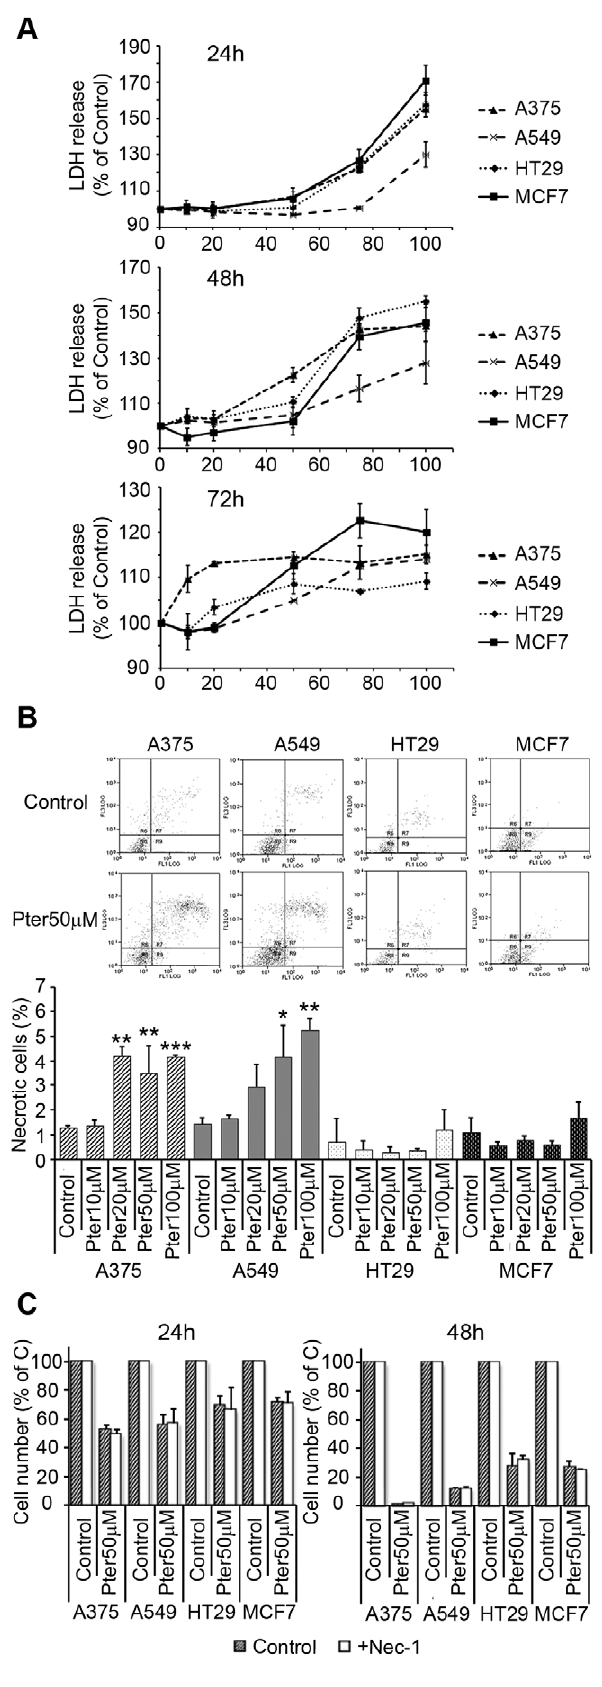
Figure 5. Effect of pterostilbene on necrosis induction. A) Release of LDH activity to the extracellular medium. Cells were exposed to Pter for 24, 48 and 72 h. Results are expressed as relative LDH activities 6 SD (n=3) where control was set to 100%. B) Propidium iodide fluorescence was plotted against annexin-V fluorescence 24 h after treatment. Results are expressed as total percentage of necrotic cells 6 SD (n=3). C) Effect of Pter on tumor cell number in the presence of the necroptosis inhibitor 5-(Indol-3-ylmethyl)-(2-thio-3-methyl)hy- dantoin (Nec-1, Calbiochem). Nec-1 25 m M was added 1 h prior to the addition of 50 m M Pter. Cell number was analyzed 24 and 48 h later. Results are expressed as relative proliferation index 6 SD (n=3) where control is 100%. The results were statistically analyzed by ANOVA and contrasted by the Tukey test (***p , 0.001; **p , 0.01; *p , 0.05 Vs.